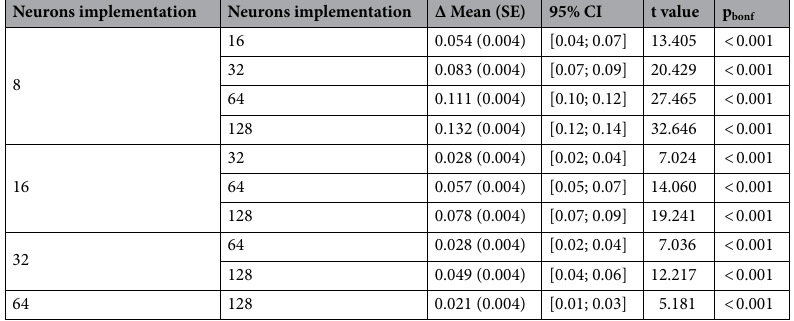
Table 1. Within-subjects effects of the memory parameter (neurons implementation).